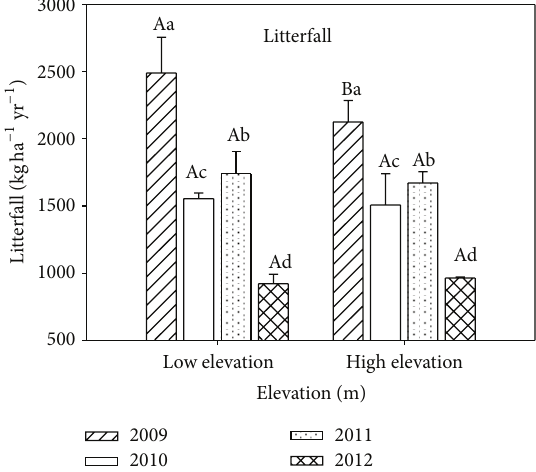
Figure3:Averageannuallitterfallofmosobambooattwoelevations from January 2009 to December 2012. Different capital letters in different group at two elevations meant significant difference at 0.05 levels in the same year, and different lower case letters at the same elevation meant significant difference in four